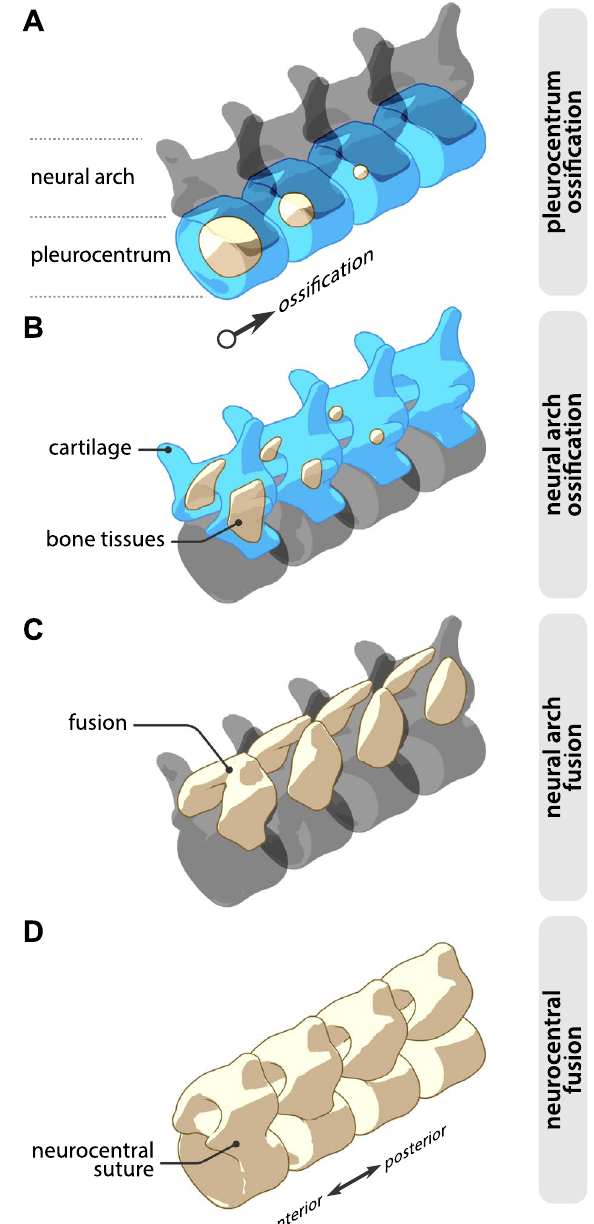
Figure 1. Schematic illustration of the four vertebral ossification patterns examined in the present study. ( A ) Pleurocentrum ossification. ( B ) Neural arch ossification. ( C ) neural arch fusion. ( D ) neuro central